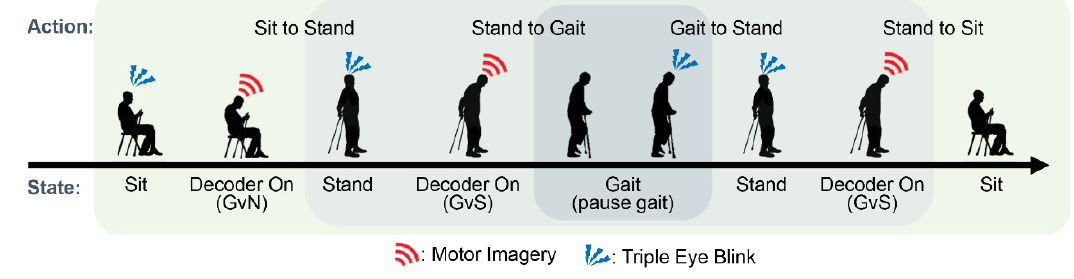
Figure 5. The illustration of the online exoskeleton operation plan. All subjects drove exoskeleton with the scenario of stand-up, gait, pause, resume gait, stop, and sit-down. The subjects completed the procedure two times (one with the BCI controller and the other with the smartwatch controller) to compare the performance of the developed BCI controller and the smartwatch controller.